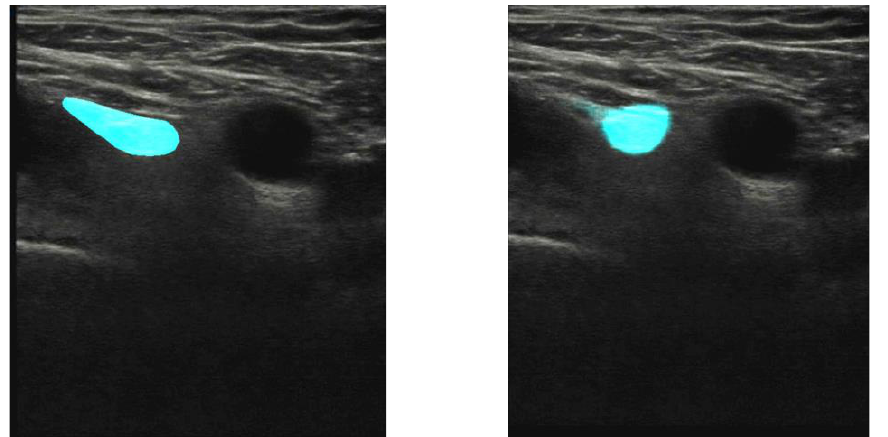
Figure 4. Test image of a participant’s right groin, the same as used in Figure 1. The femoral artery is seen as a black circular area in the center of the image. Left panel: expert’s manual annotation of the femoral nerve (cyan). Right panel: trained U-net segmentation of the femoral nerve. The overlap between the annotated and segmented areas, described as IoU, is 57% in this case.